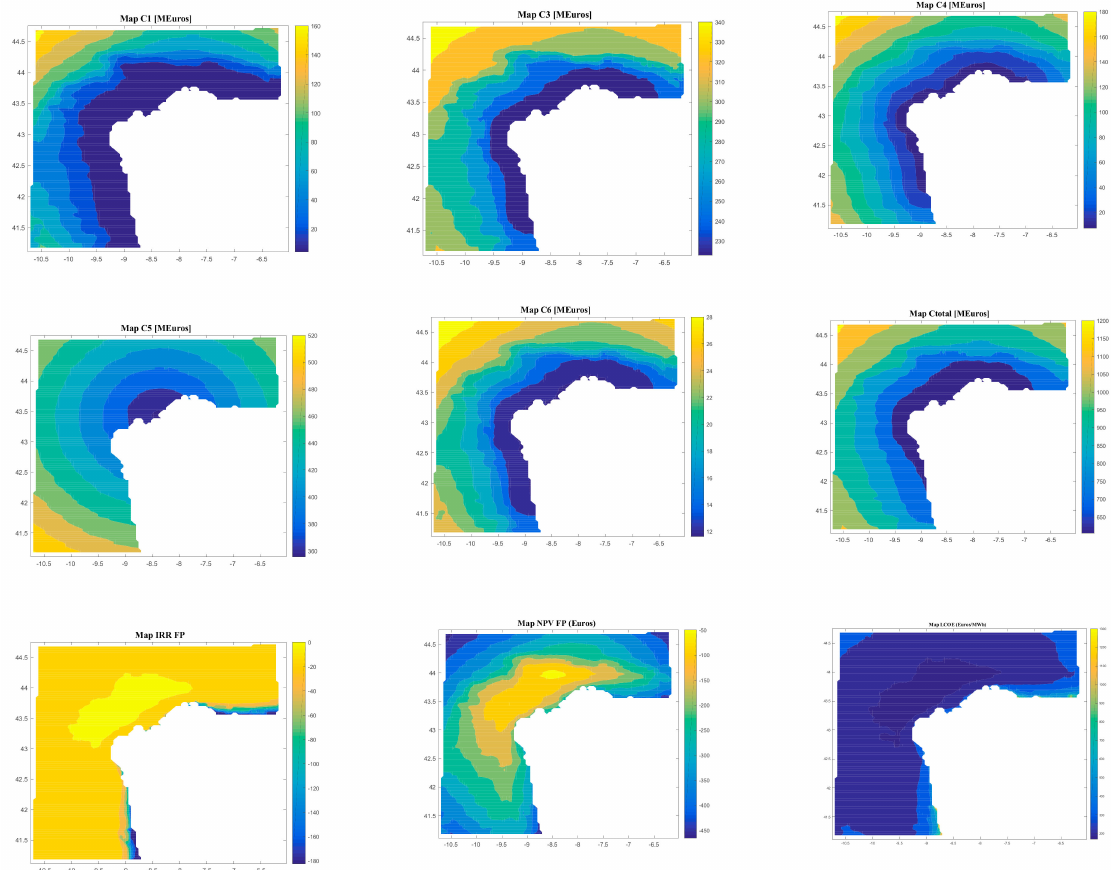
Figure 11. Results (C1, C1, C3, C4, C5, C6, Ctotal, LCOE, DPBP, IRR, NPV) for Case